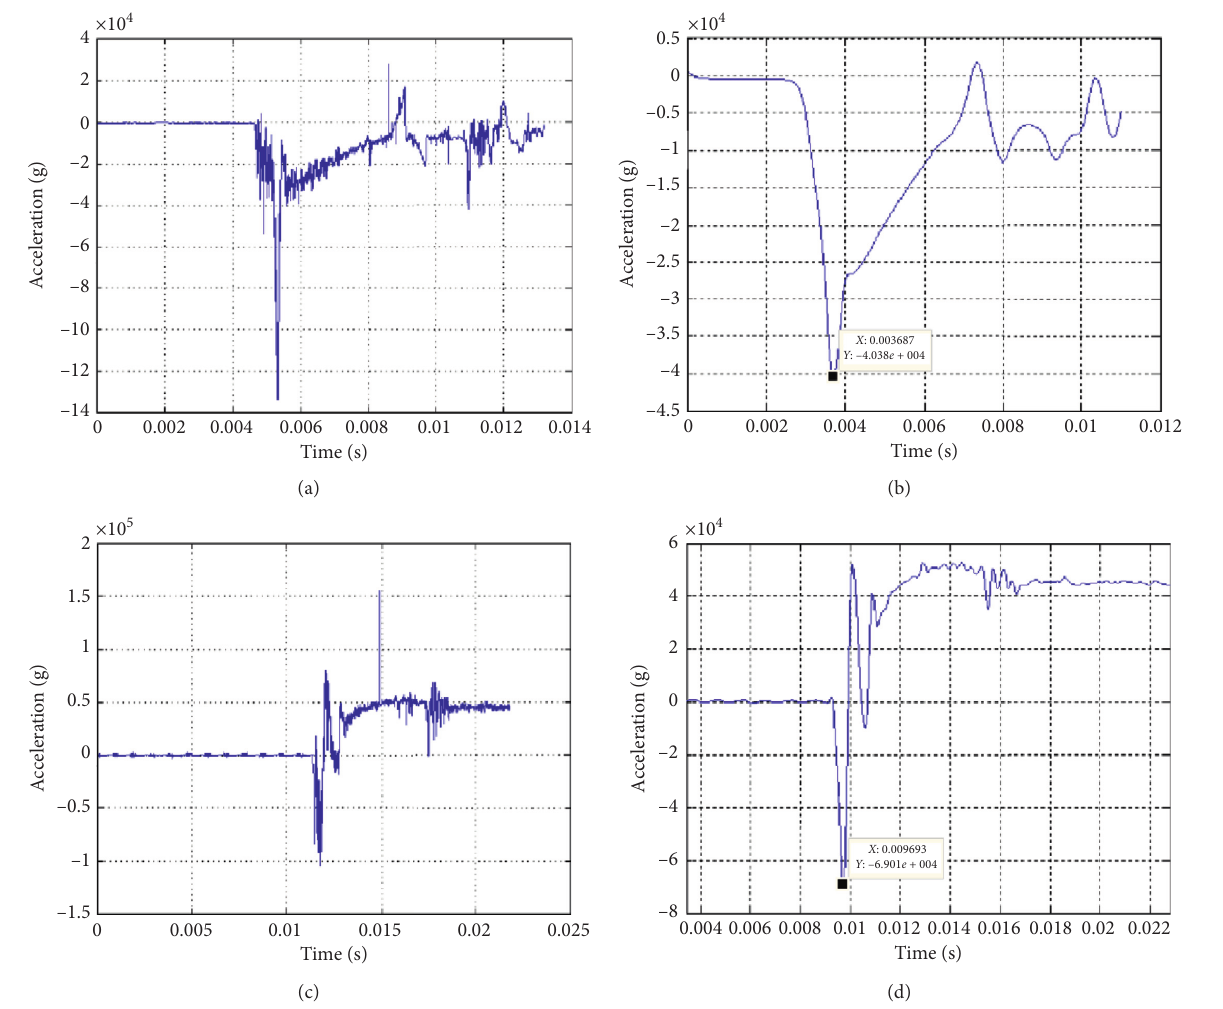
Figure 16: Waveform chart in the penetration process: (a) the original signal collected by acceleration sensor 1#; (b) the filtered signal collected by acceleration sensor 1#; (c) the original signal collected by acceleration sensor 2#; (d) the filtered signal collected by acceleration sensor